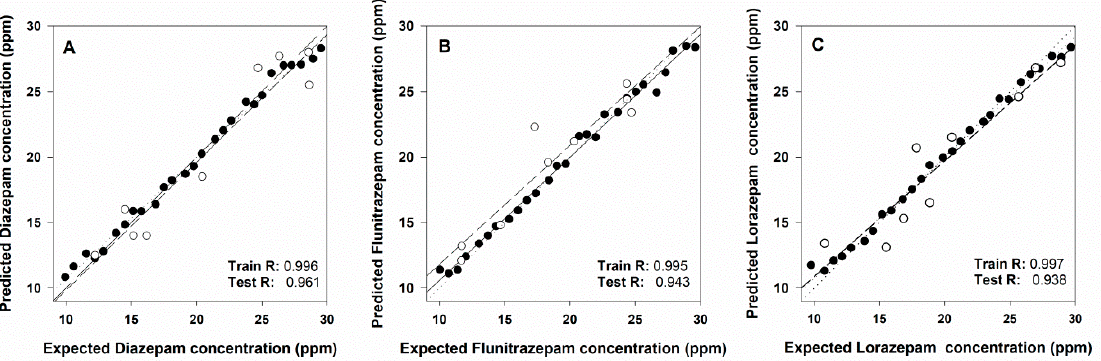
Figure 8. Obtained vs. expected concentrations results plots for the training set (black dots) and the testing set (white dots) for ( A ) diazepam, ( B ) flunitrazepam, and ( C ) lorazepam.